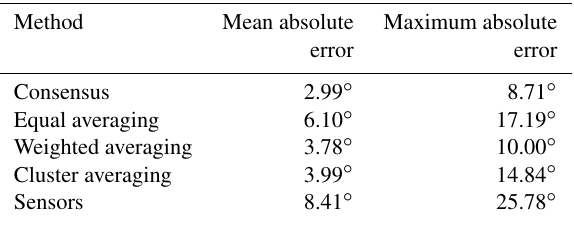
Table 1. Results of different methods. The mean absolute error col- umn is also plotted in the lower right subplot of Fig. 6. The consen- sus method also has the smallest maximum